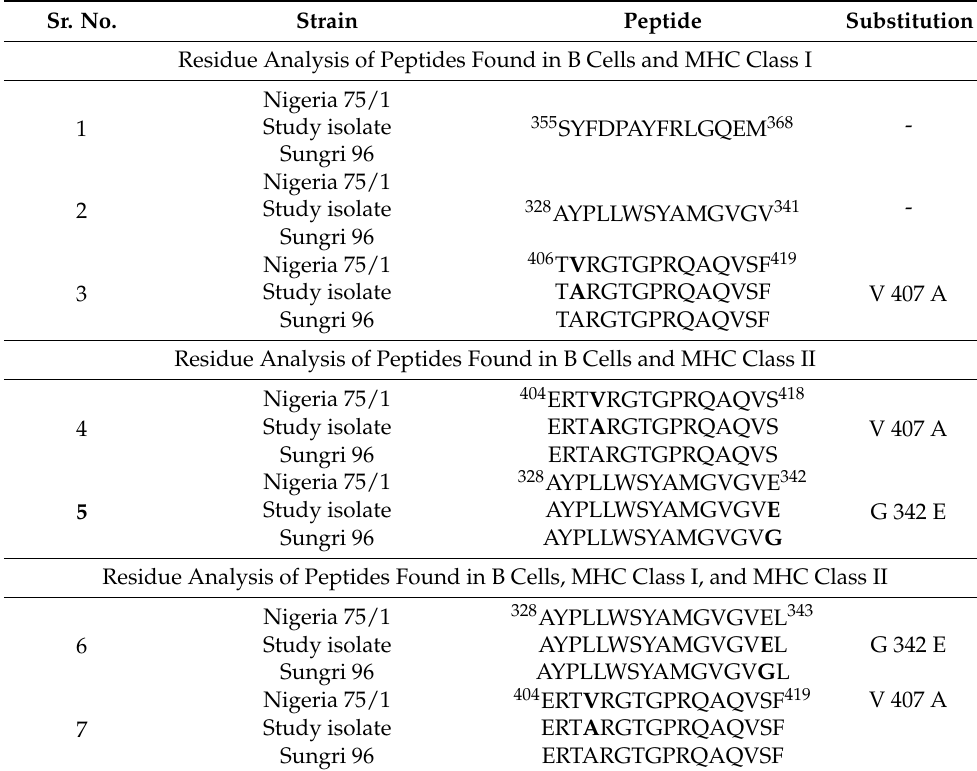
Table 1. Comparative substitution analysis of nucleocapsid protein of studied isolates and vaccinal strains (Nigeria 75/1 and Sungri